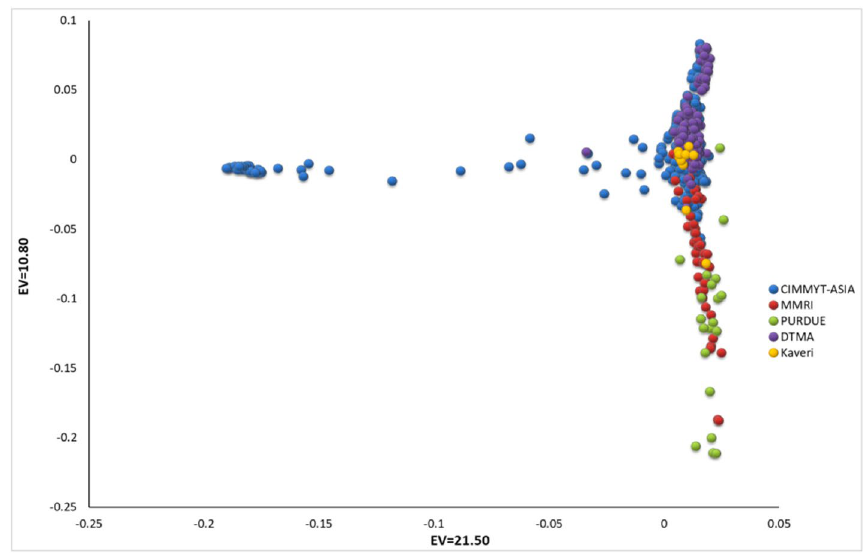
Figure 1. Grouping of accessions of HTAM panel based on first two Principal components.